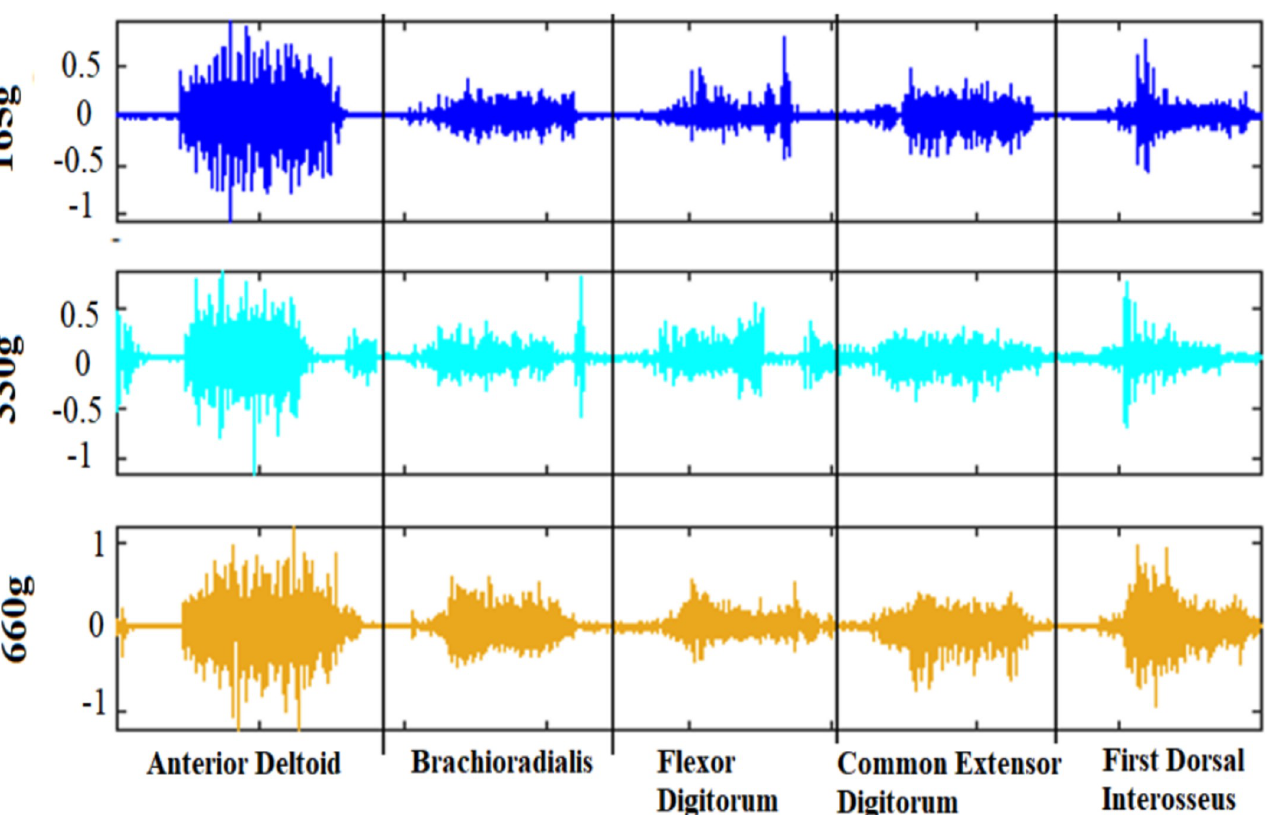
Fig 3. Raw EMG signals of 5 muscles. (Anterior Deltoid, Brachioradialis, Flexor Digitorum, Common Extensor Digitorum, and First Dorsal Interosseous) for 3 different weights (165, 330, and 660 g).